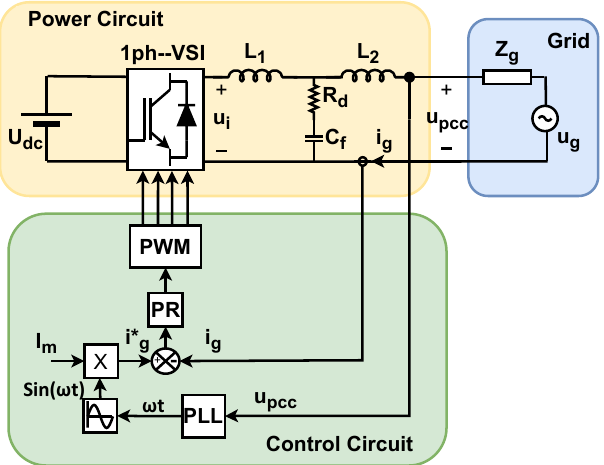
Figure 7. System diagram of the detailed description of the single inverter system.